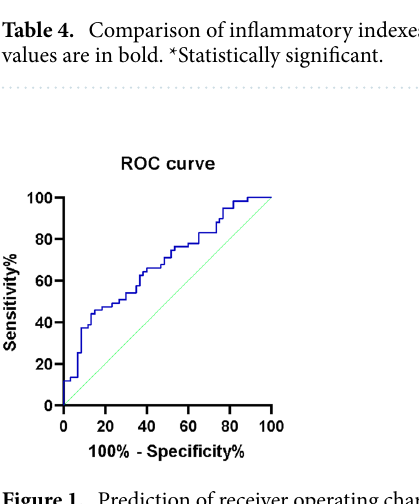
Figure 1. Prediction of receiver operating characteristic (ROC) curves in Perthes disease with PLR. The area under ROC curve (AUC) was 0.679, P =